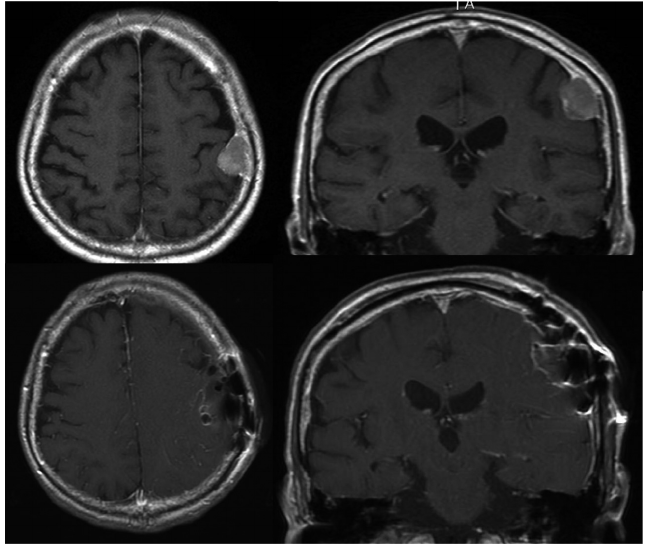
Fig. 1. Axial and coronal MRI with contrast enhancement before and after surgery. Axial (Panel 1) and coronal (Panel 2) MRI with contrast enhancement (Panel A, before surgery; Panel B, one week after surgery) shows brain tumor located in the left S1 of IPL, which was totally